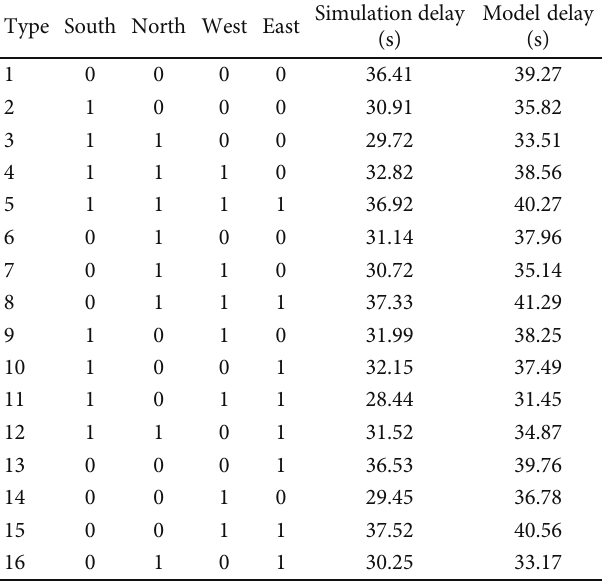
Table 9: Comparison of the average vehicle delay of 16 schemes of variable guidance lane